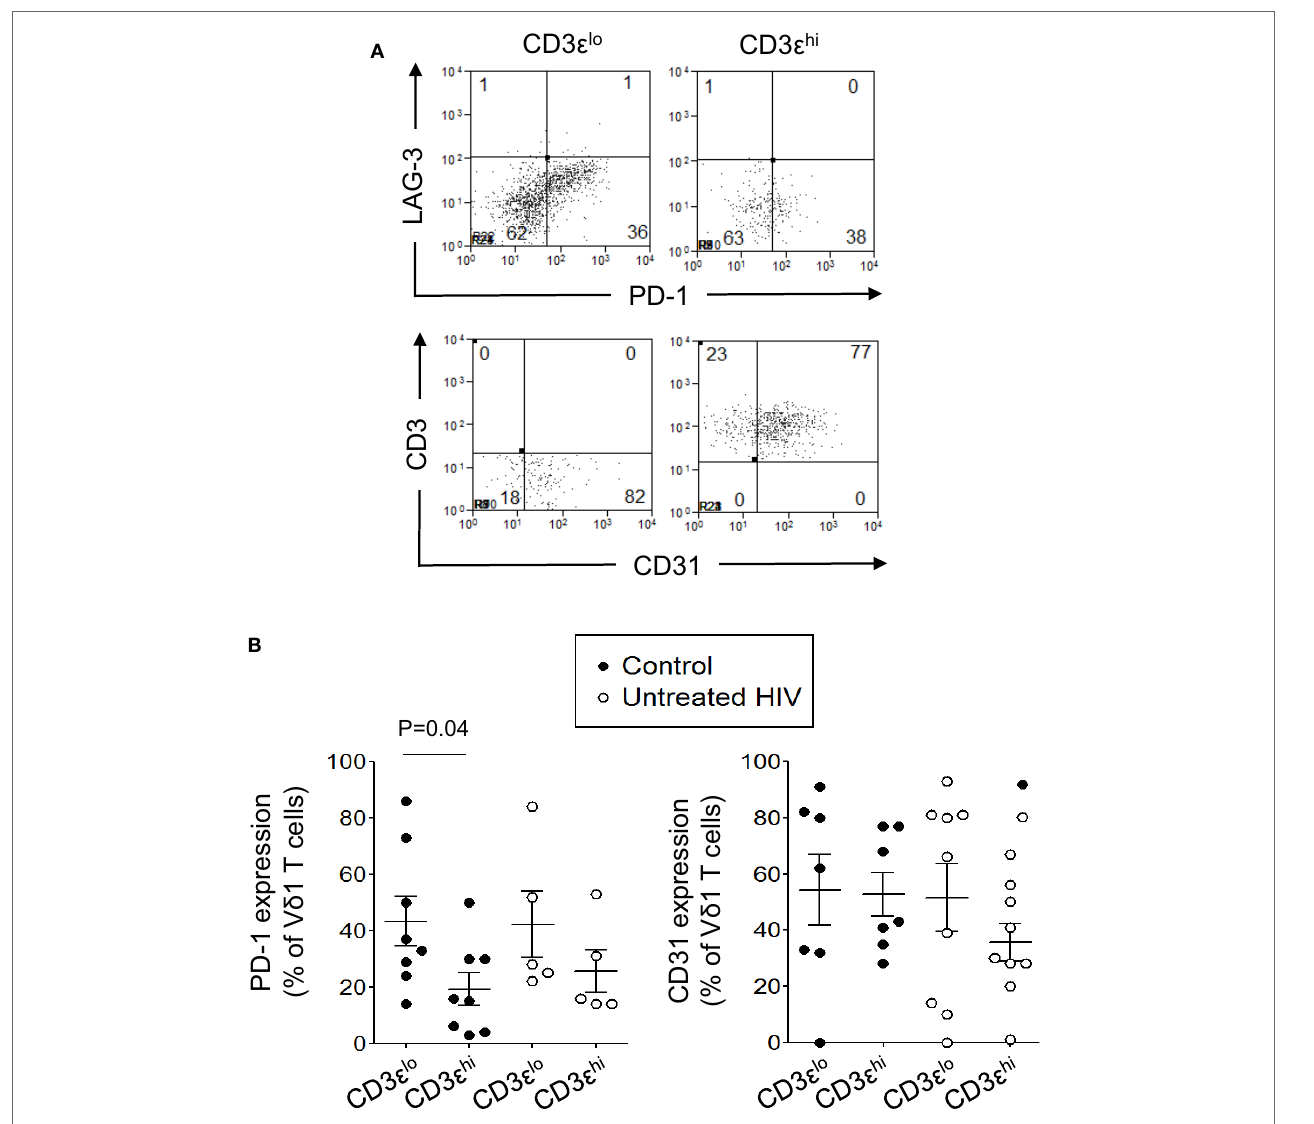
FigUre 7 | CD3 ε lo V δ 1 T cells more frequently express programmed death-1 (PD-1), but not lymphocyte-activation gene 3 (LAG-3) or CD31, than CD3 ε hi V δ 1 T cells. Peripheral blood mononuclear cell prepared from eight healthy donors and five untreated patients with human immunodeficiency virus (HIV) were enriched for γδ T cells using magnetic bead separation, stained with monoclonal antibodies specific for CD3 ε , V δ 1, PD-1, LAG-3, and CD31 and analyzed by flow cytometry. (a) Flow cytometry dot plots showing PD-1, LAG-3, and CD31 expression by gated CD3 ε lo and CD3 ε hi V δ 1 T cells from a patient with HIV. (B) Scatter plots showing the frequencies of CD3 ε lo and CD3 ε hi V δ 1 T cells from the patients with HIV and control subjects that expressed PD-1 and CD31. Groups were compared using the Mann–Whitney U